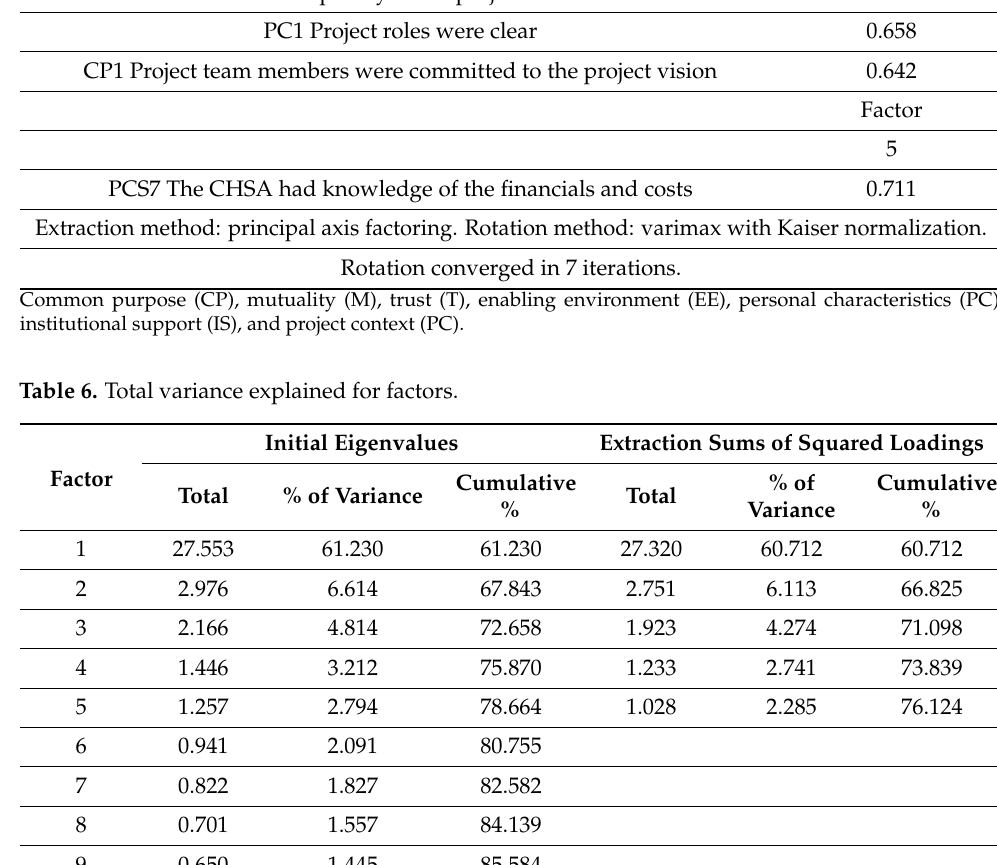
Extraction method: principal axis factoring. Rotation method: varimax with Kaiser normalization. Rotation converged in 7 iterations.